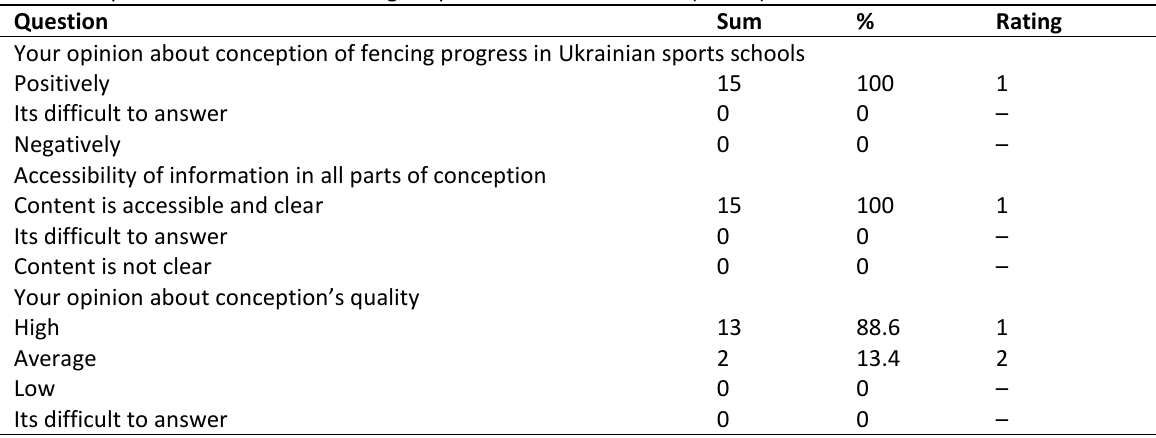
Table 1. Experts’ assessment of fencing in sports schools of Ukraine (n = 15) Question Sum %